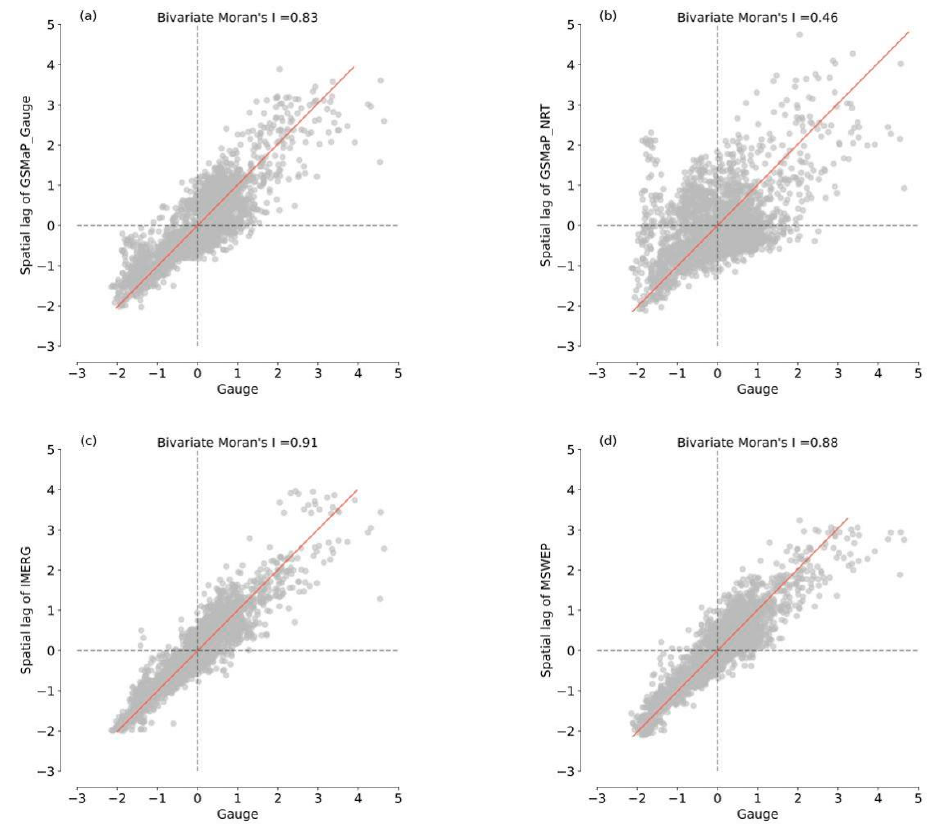
Figure 11. The global BMI scatter plot of Rmax between the gauge observations and the four SPPs: ( a ) GSMaP_Gauge, ( b ) GSMaP_NRT, ( c ) IMERG, and ( d ) MSWEP.